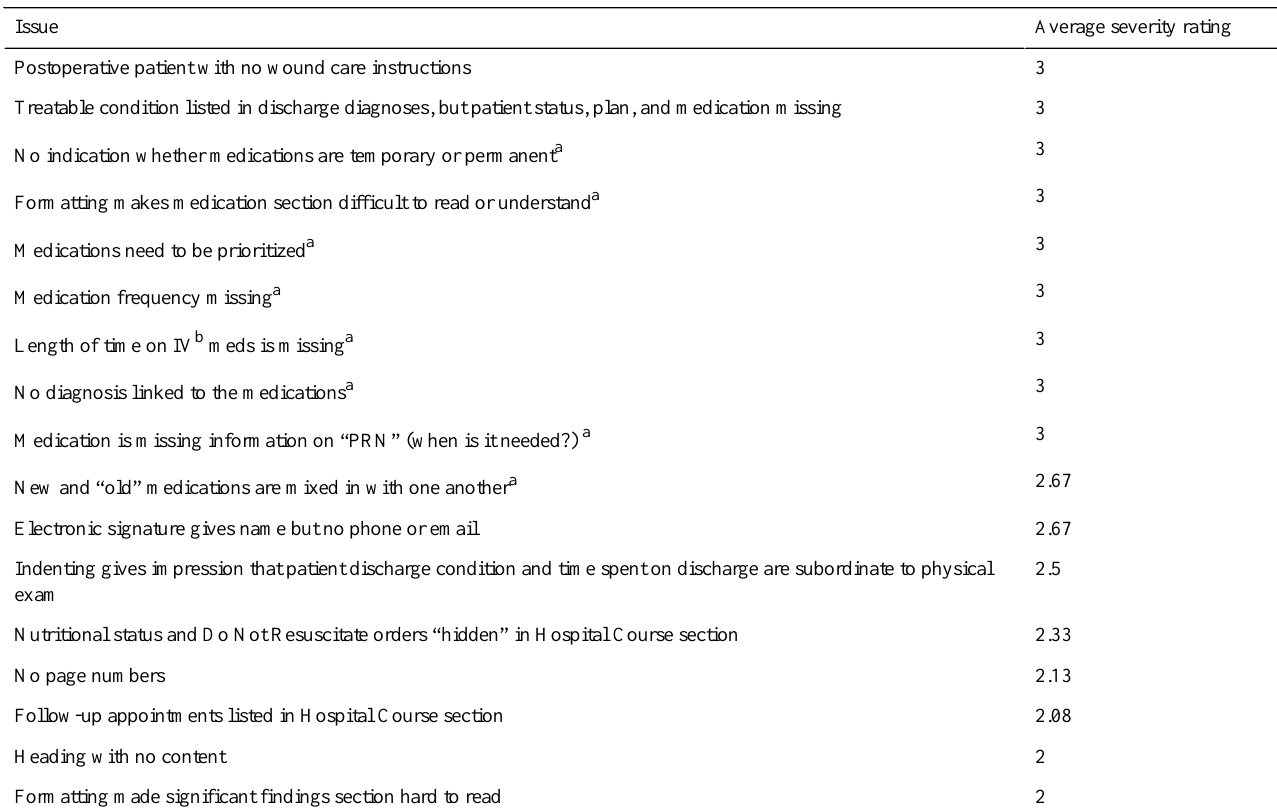
Table 4. Usability issues with average severity ratings ≥